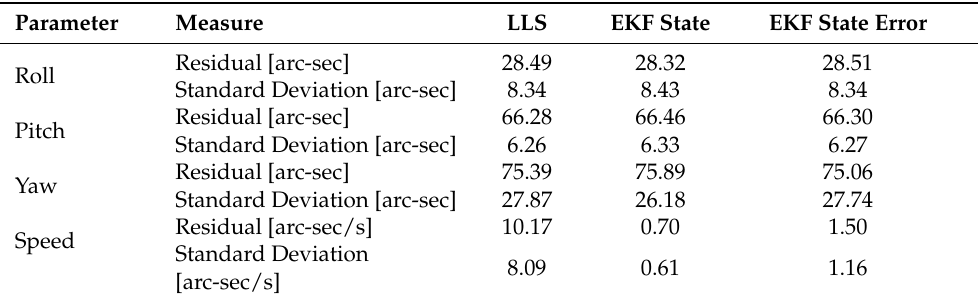
Table 4. EKF results with real night sky imagery using a 1 s time displacement between each image, and so an angular speed of 36